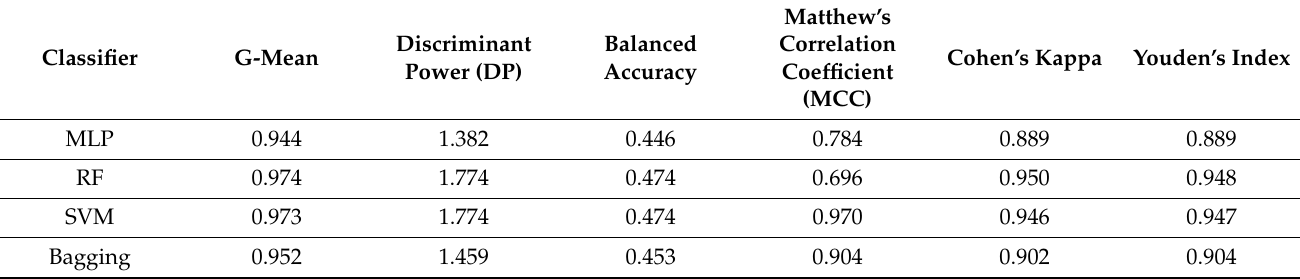
Table 5. Metrics values of the combined performance